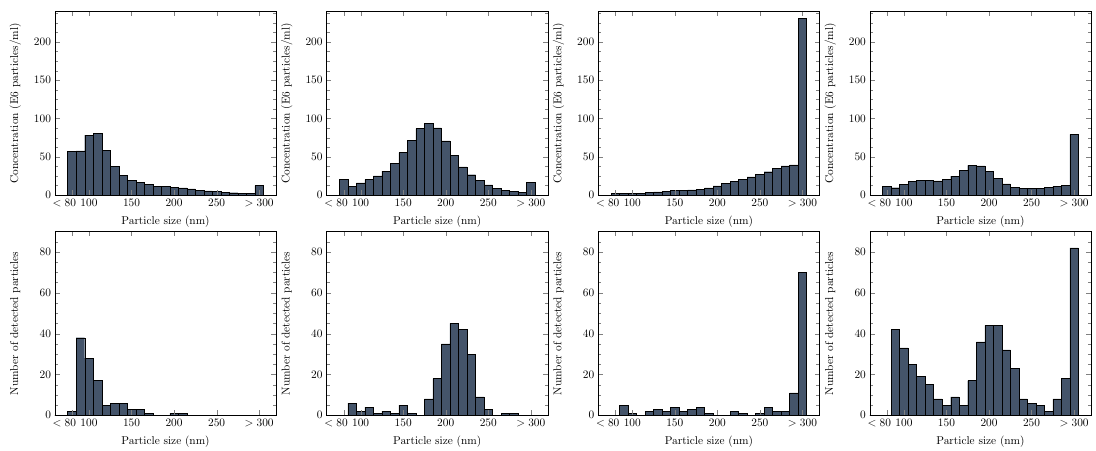
Figure 6. Experiment results for four different suspensions analysed by the PAMONO-sensor. The order of results for suspensions is the following (from left to right): solo 100 nm particles, solo 200 nm, solo 300 nm, the mixture of 100 nm and 200 nm and 300 nm particles. The top row shows reference distributions obtained with the LM10 device while the bottom row shows PAMONO-sensor